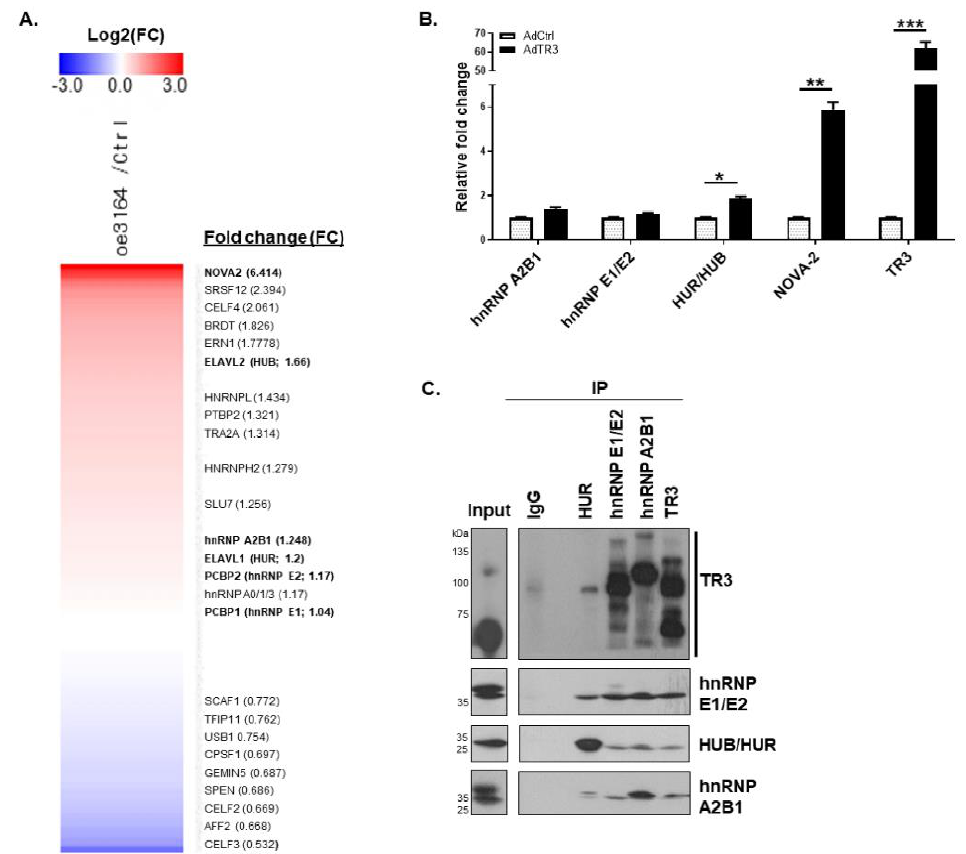
Figure 3. TR3 physically interacts with some splicing factors involved in the AR splicing process. ( A , B ) TR3 overexpression alters the expression level of some factors involved in the splicing of AR pre-mRNA. Heatmap of RNA–seq data showing alterations in the expression level of some splicing factors in TR3-overexpressing CWR22Rv1 cells ( A ). qPCR analysis presenting mRNA levels of several splicing factors (hnRNP A2B1, hnRNP E1/E2, HUB/HUR, and NOVA-2) in CWR22Rv1 cells infected with AdTR3 or AdCtrl ( B ). Data are shown as mean ± SEM. *, p < 0.05; **, p < 0.01; ***, p < 0.001; one-way ANOVA analysis with Tukey’s post-hoc test. ( C ) TR3 physically interacts with splicing factors involved in the splicing of AR pre-mRNA. Representative immunoprecipitation (IP) analysis showed physical interactions between TR3 and several splicing factors (hnRNP A2B1, hnRNP E1/E2, and HUB/HUR) in CWR22Rv1 cells infected with AdTR3. Immunoprecipitation was performed using anti-TR3, anti-hnRNP A2B1, anti-hnRNP E1/E2, and anti-HUR antibodies. Protein levels were analyzed via western blot analysis using anti-TR3, anti-hnRNP A2B1, anti-hnRNP E1/E2, and anti-HUR antibodies. All uncropped western blot original images are shown in Figure